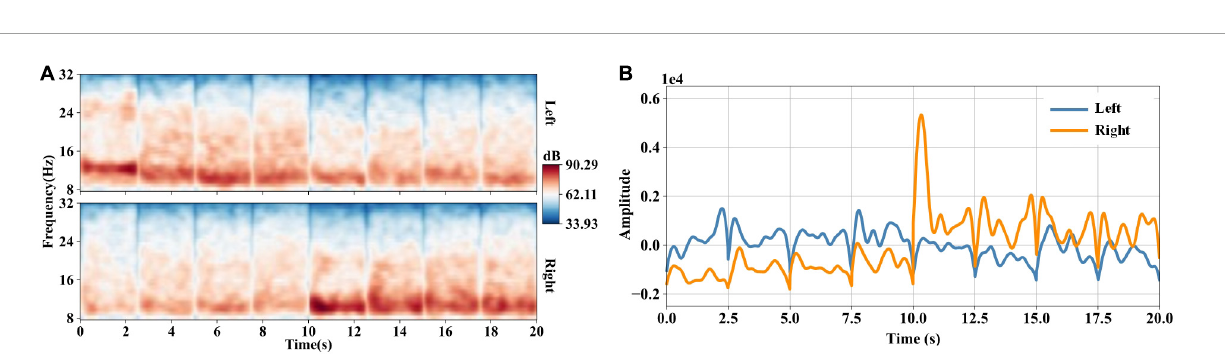
FIGURE4 (A) Concatenated time-frequency maps averaged across trials of subject S9. After CSP filtering, we obtain eight channels’ data with a time window of 2.5 s. We transform the CSP-filtered data into the time-frequency domain and get eight time-frequency data segments. Then we concatenate the eight time-frequency data segments, forming the concatenated time-frequency data of 20 s. (B) Waveforms of the templates at the optimal frequency point (11.87 Hz) of subject S9. After data concatenation, the optimal frequency points for classification are selected through the method of section “2.5.3. tCSP feature selection”. The templates are calculated using training concatenated time-frequency data at the optimal frequency